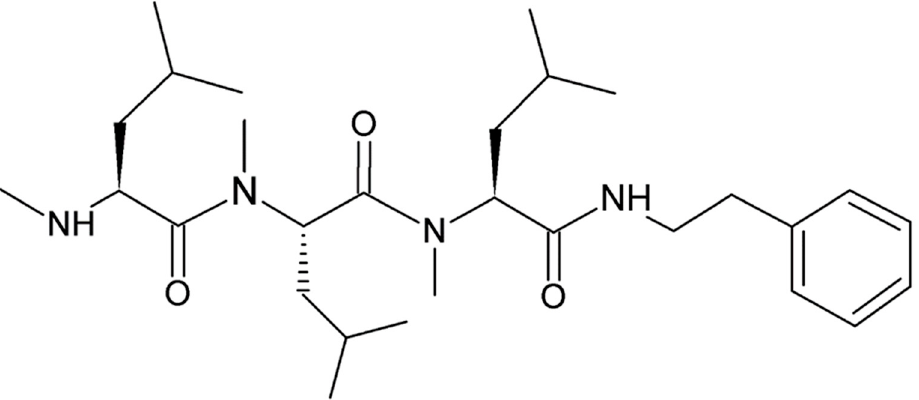
Figure 1. Structure of the rhabdopeptide produced by VietABC, consisting of three N -methylated L -leucine residues and the C-terminal condensed phenethylamine [10].